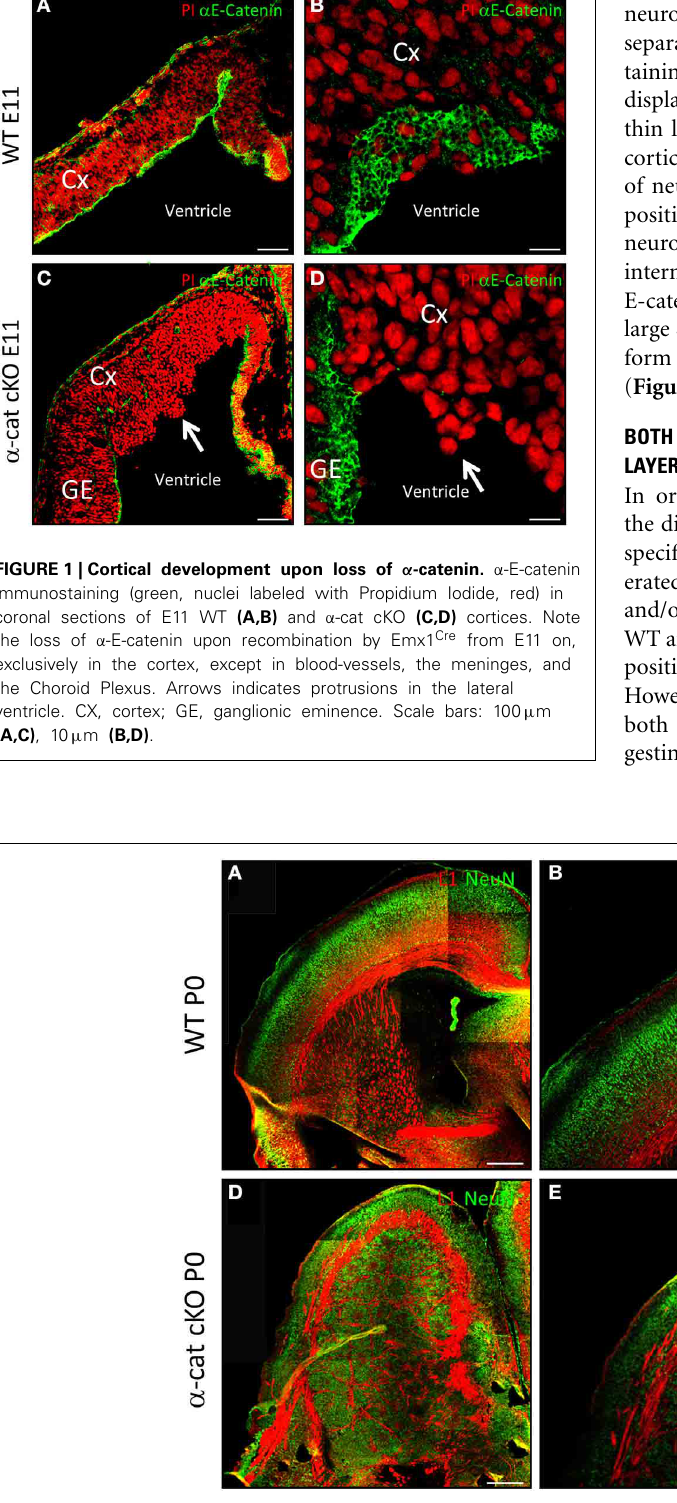
cortex; (B,E) : enlarged view of (A,D) ; (C,F) : connection between the two hemispheres [corpus callosum in (C) ]. Scale bars: 200 μ m (A,D) , 100 μ m (B,C,E,F)